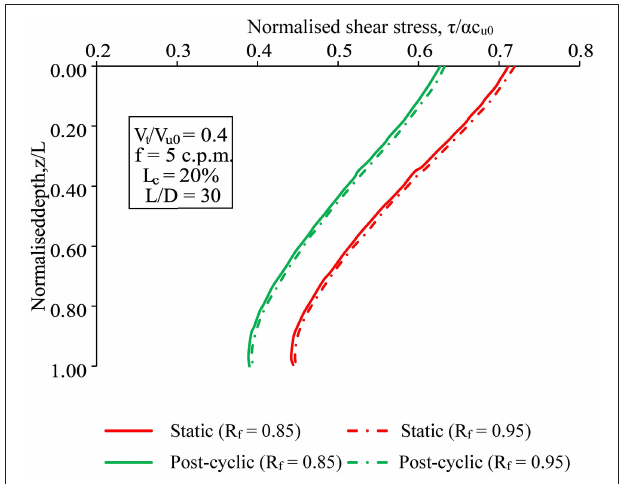
FIGURE 7 | Normalized interface shear stress profile of pile for static and post-cyclic